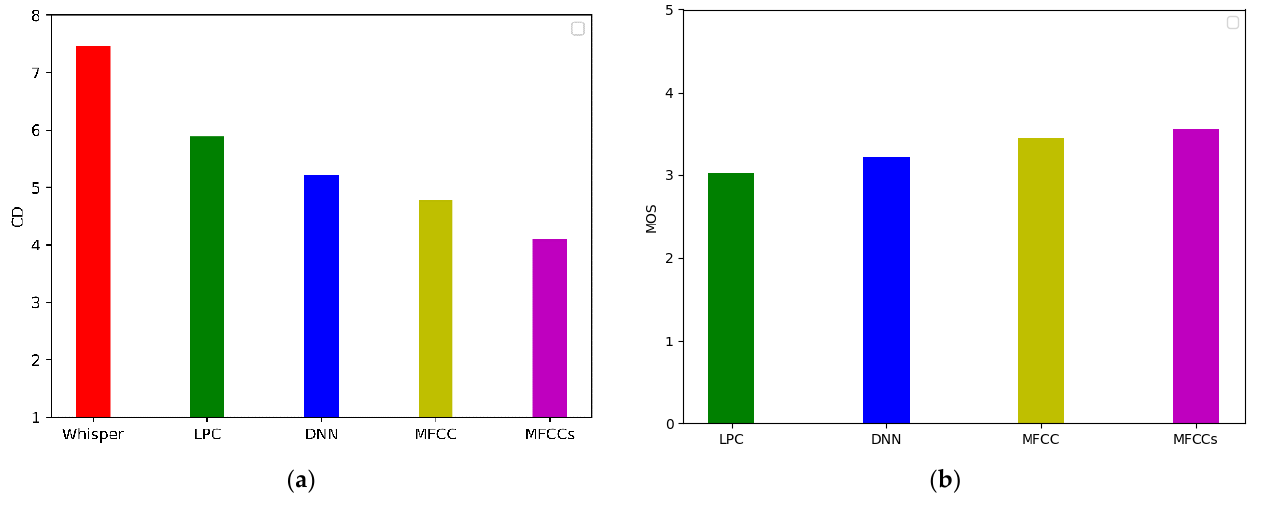
Figure 5. ( a ) Cepstral distances between normal speech with whispered speech and converted speeches using LPC, DNN, MFCC and MFCCs. ( b ) MOS with 95% confidence w.r.t LPC, DNN, MFCC and MFCCs.